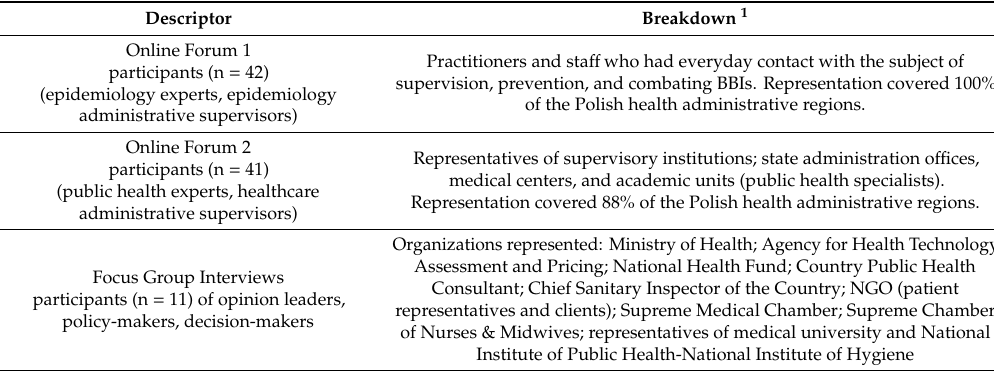
Table 1. Profile of interviewees and knowledge supporters.